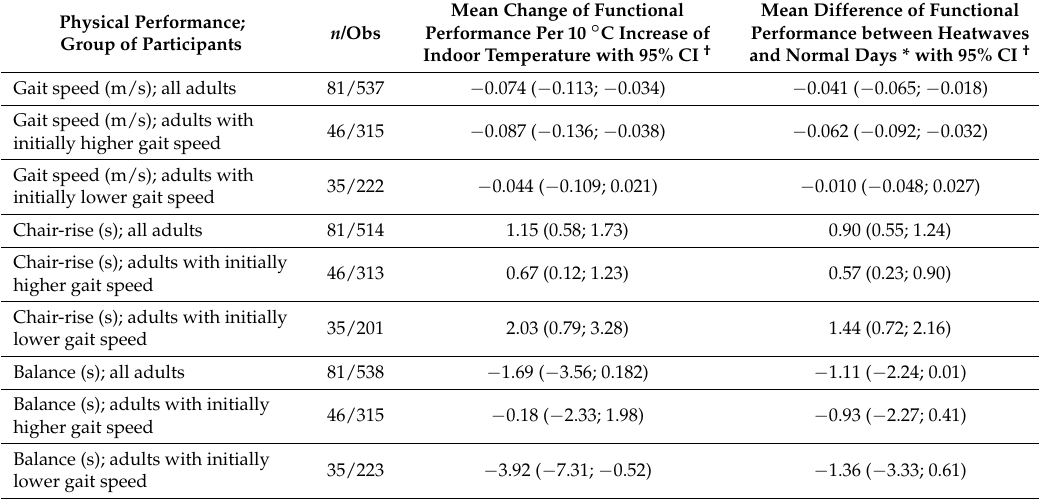
Table 2. Mean changes of functional performance with increasing indoor temperature and mean differences of functional performance between heat waves and normal